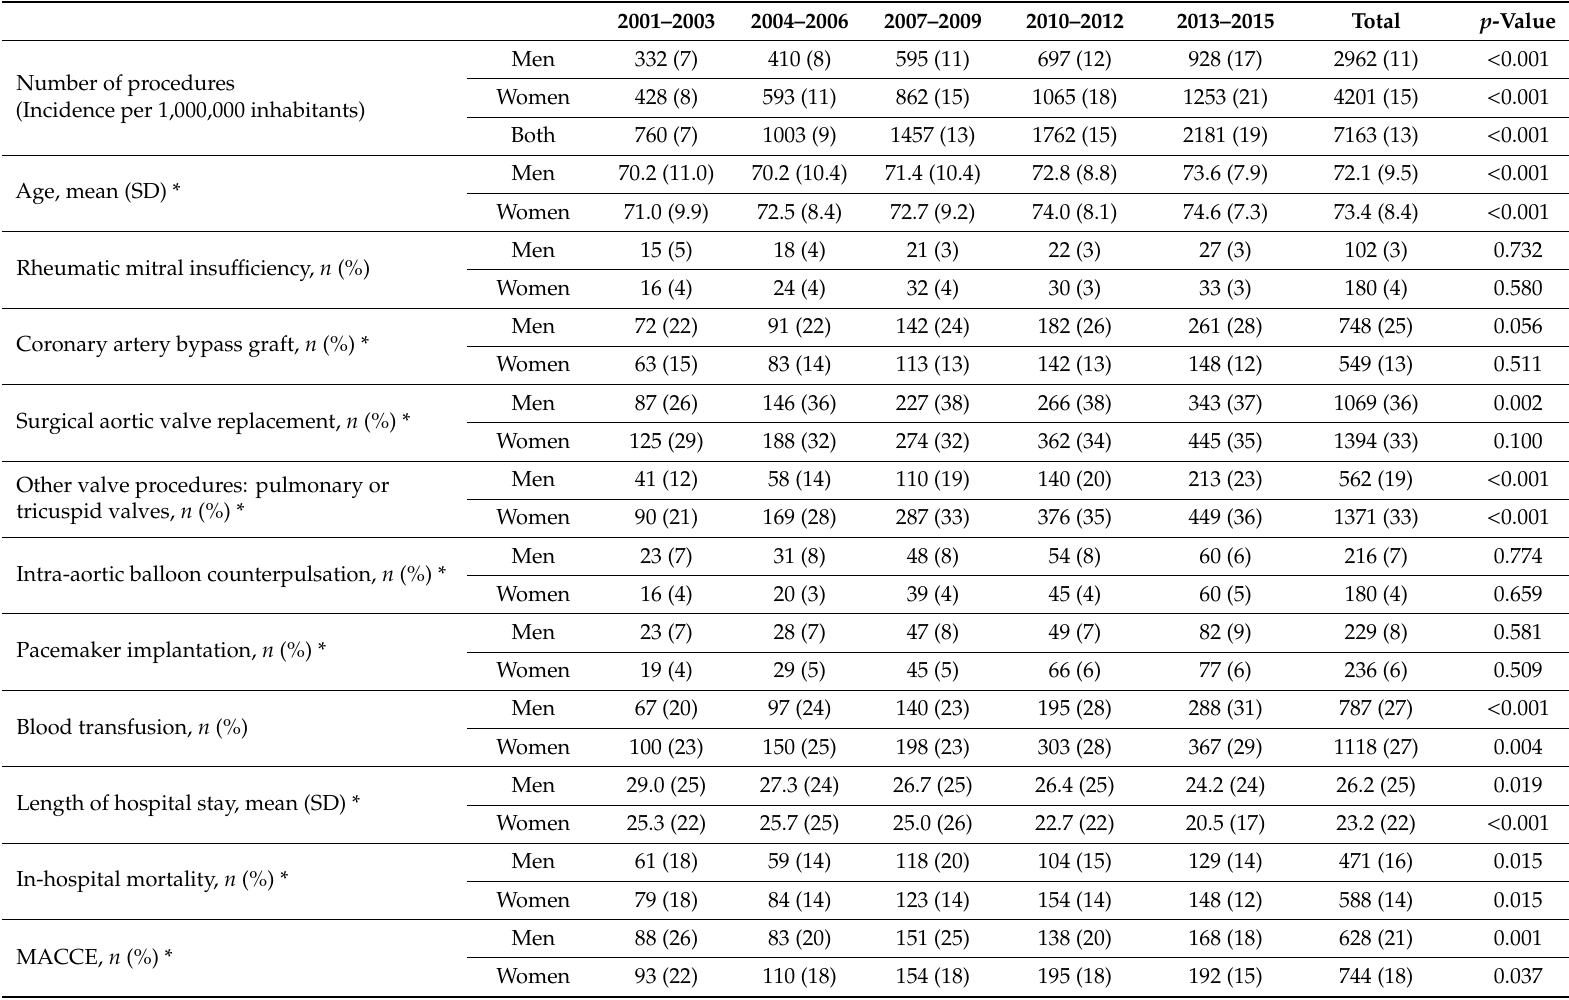
Table 2. Incidence, sociodemographic and clinical characteristics of hospitalized patients undergoing bioprosthetic mitral valve replacement in Spain from 2001 to